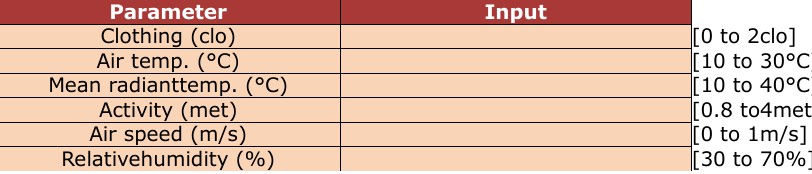
Table 7. Sample PMV key variables